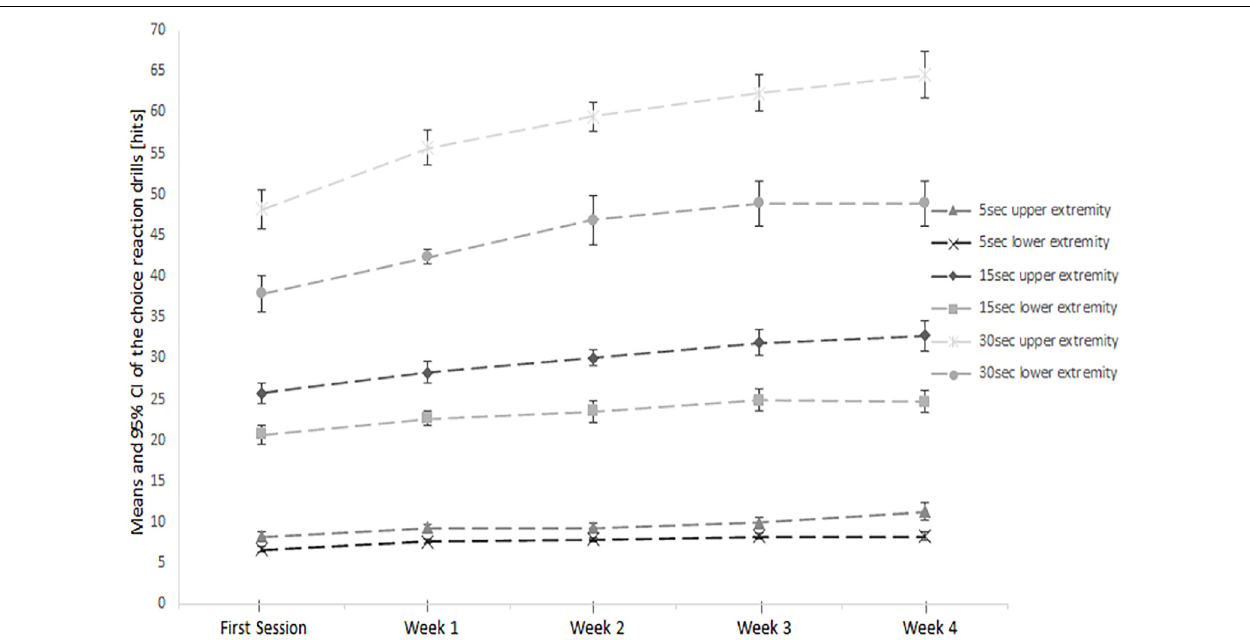
FIGURE 3 | Means and 95% confidence intervals of the absolute number of correct hits in the 15 s open skill visuomotor choice reaction drill during the 4-week training